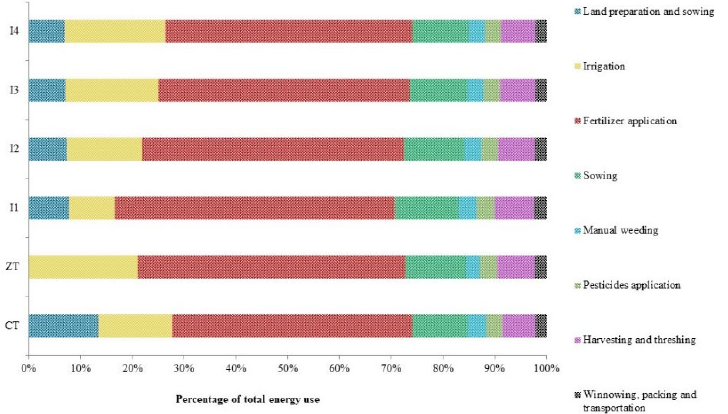
Figure 3. Source ‐ wise energy input under different tillage and irrigation management practices.